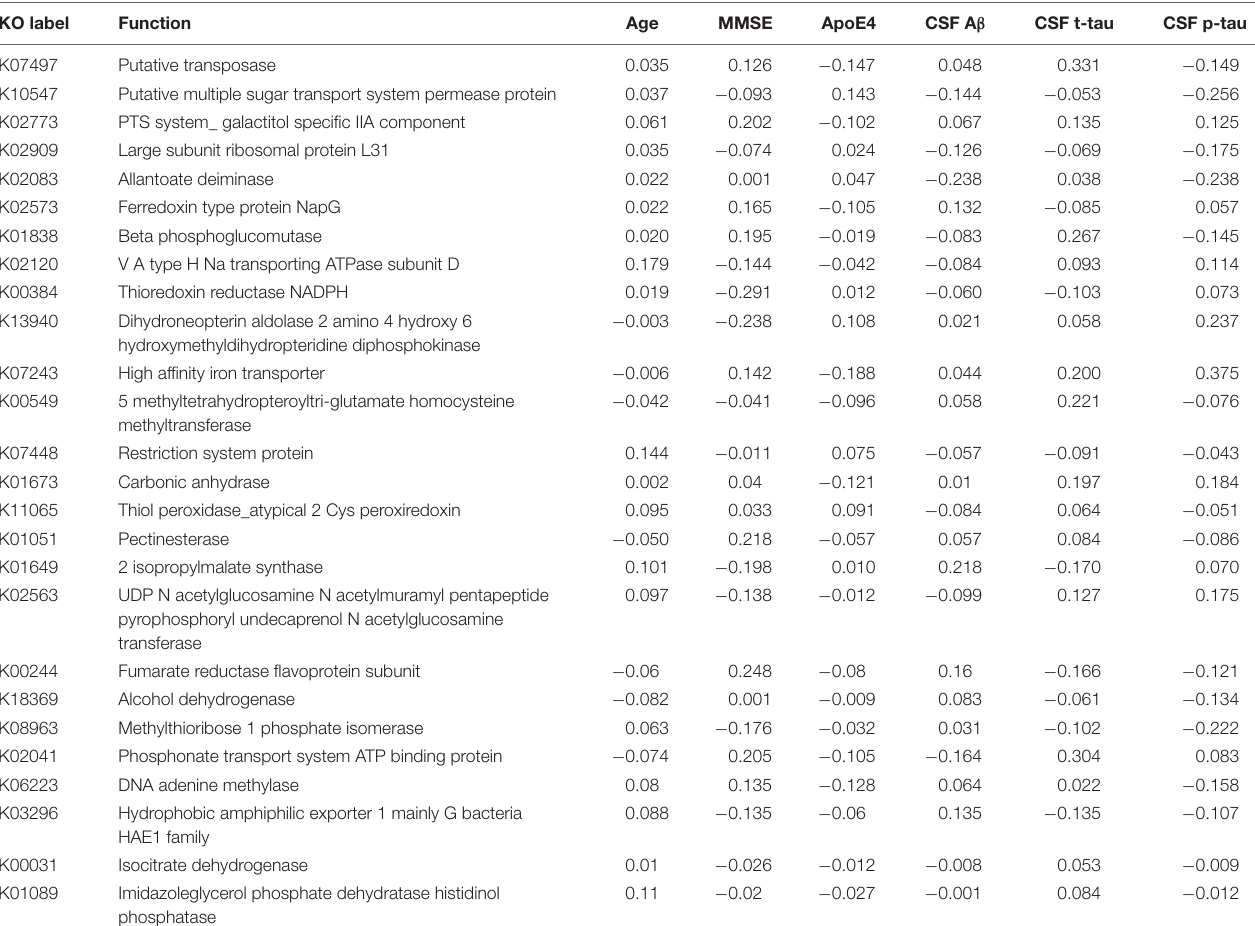
TABLE 7 | The associations between KO [Kyoto Encyclopedia of Genes and Genomes (KEGG) ortholog] features and Alzheimer’s disease (AD) clinical and biomarker